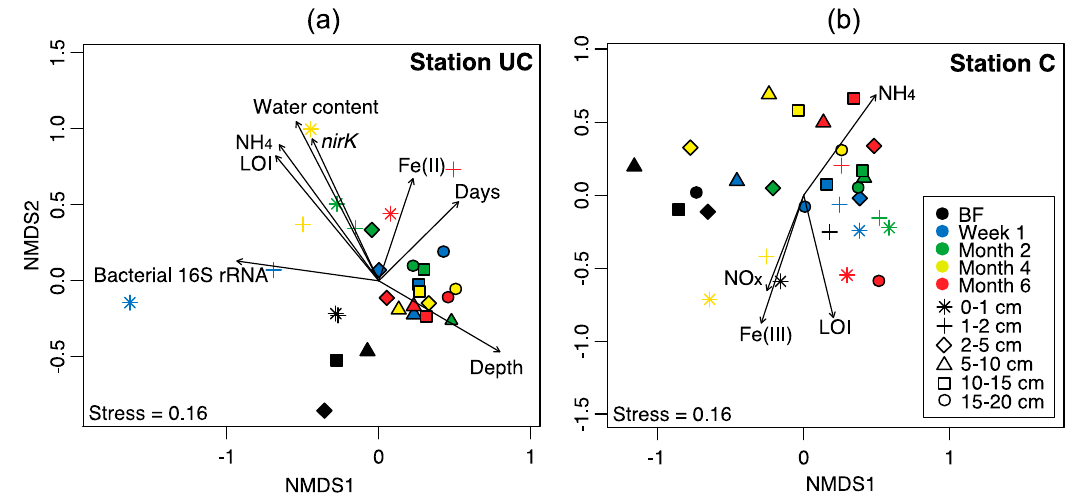
Figure 7. NMDS ordination of Bray–Curtis dissimilarities from T-RFLP analyses shown separately for: ( a ) station uncultivated (UC); and ( b ) cultivated (C). The samples are from before flooding (BF) and one week, two, four and six months after the soil cores were flooded with seawater. Colors correspond to the sampling time points and symbols represent the different soil depths. Environmental data were overlaid as vectors on the ordinations. Significantly correlating environmental data were soil depth in centimeter (depth), number of days after flooding (days), copy numbers of bacterial 16S rRNA, copy numbers of the nirK gene, percentage water content, ferrous iron content [Fe(II)], ferric iron content [Fe(III)], loss on ignition (LOI) a measure of soil organic matter content, ammonium content (NH 4 ), nitrate+nitrite content (NO x ).